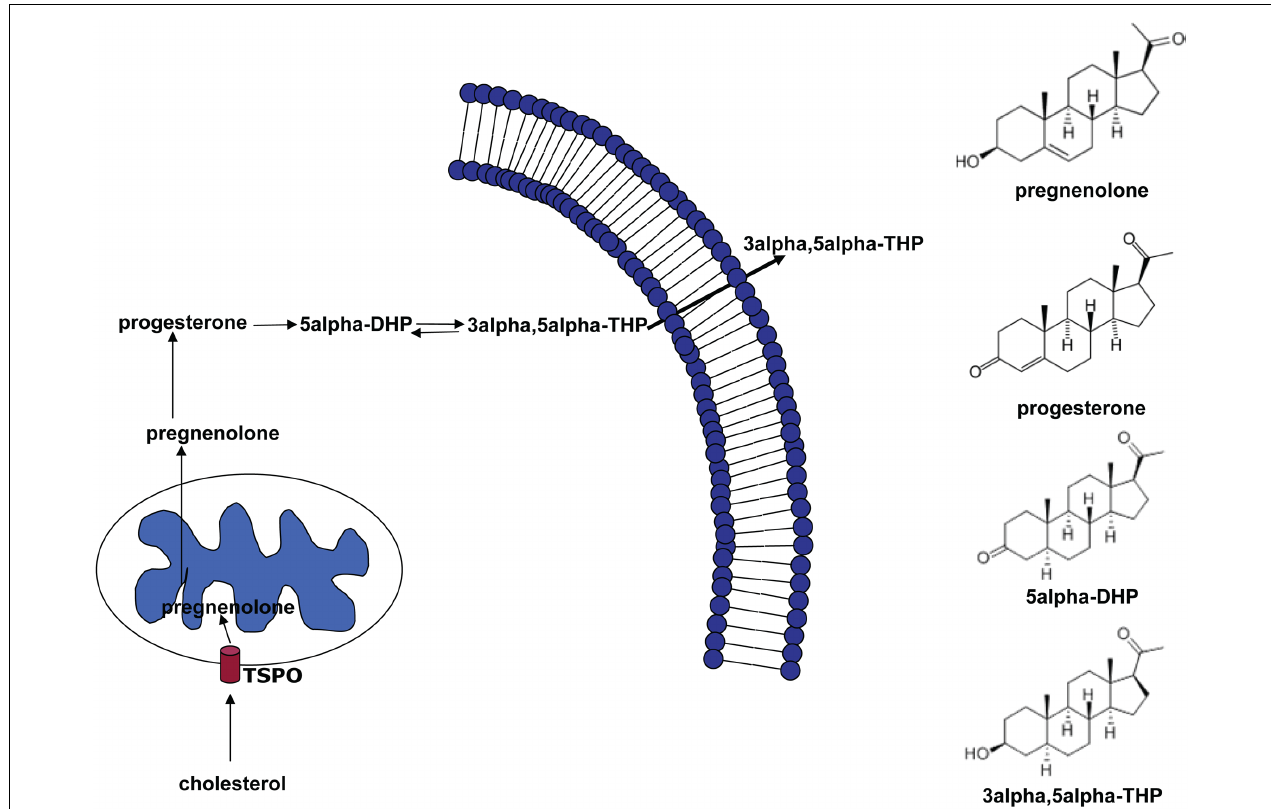
FIGURE 1 | Biosynthetic pathway of 5 α -dihydroprogesterone and 3 α , 5 α -tetrahydroprogesterone (3 α , 5 α -THP). The rate-limiting step is the cholesterol translocation into the mitochondria by the mitochondrial translocator protein (18kDa;TSPO).The figure shows the chemical structures of the main NS involved in this